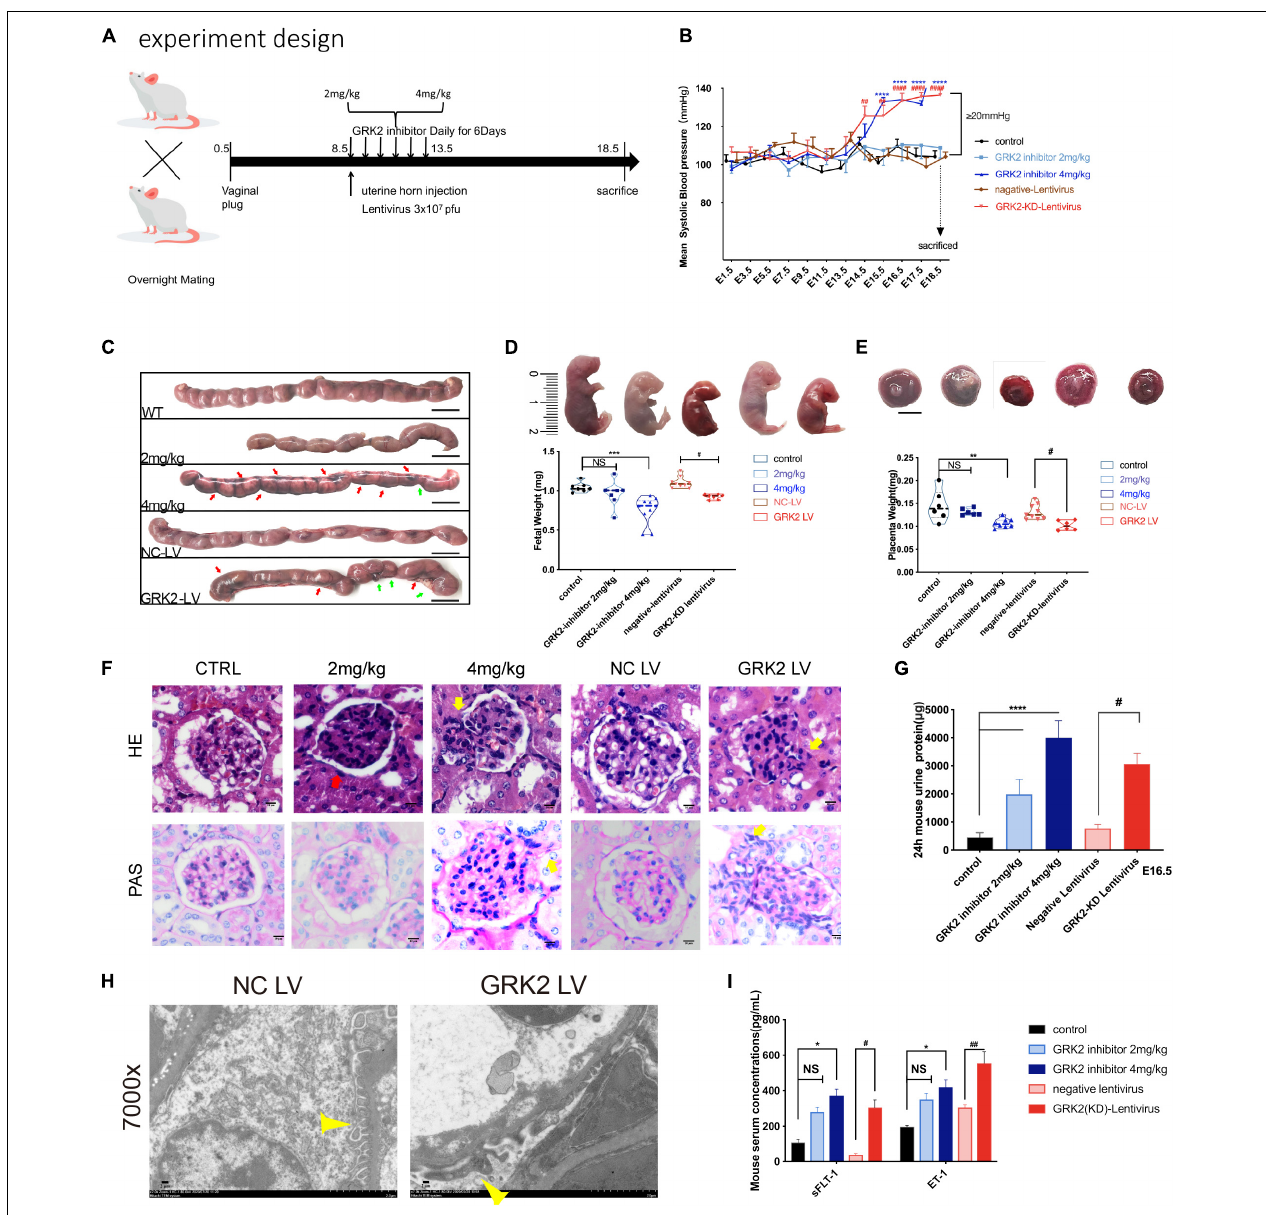
FIGURE 2 | Knockdown or inhibition of GRK2 in placenta induces PE-like phenotype:hypertension, proteinuria, and angiogenic imbalance in mice. (A) Experimental design. For each group, n = 6–10 mice. (B) Blood pressure was taken in mice with/without placental knockdown or inhibition of GRK2. n > 6, Mean ± SEM. (C) Gross morphology of uterus at E18.5 shows the spontaneous hemorrhage and resorptions of embryos in uteri of GRK2 deficient groups. Green arrows, fetal resorption; red arrows, intrauterine hemorrhage. (D,E) Knockdown or inhibition of placental GRK2 induced embryo growth restriction and placenta growth restriction. (F,G) Glomerular histopathology assessment by HE (upper panel) and PAS (lower panel) staining of untreated mice and mice treated with GSK180736A (2 or 4 mg/kg), and mice receiving intrauterine injections with non-target/GRK2-knockdown lentivirus. Scale bar, 10 µ m. Mesangial hyperplasia (yellow arrow) and decreased capillary density (red arrow) are shown in GRK2-knockdown/inhibition group. (H) TEM analysis of glomerulus. Pathological podocyte fusion in GRK2-knockdown group and the podocytes in NC-LV group are indicated by thin yellow arrows; 7,000 × magnification, Scale bar, 2 µ m. (I) the sFlt1 and ET-1 abundance in serum of E18.5 mice, as determined by ELISA. sFlt1, soluble fms-related tyrosine kinase-1; ET-1, Endothelin-1. All data are represented as X ± SEM from each experiment ( n = 6–10 mice, each assayed individually), NS, not significant; * P < 0.05, ** P < 0.01, *** P < 0.001, **** P < 0.0001 versus control mice group; # P < 0.05, ## P < 0.01, ### P < 0.001, #### P < 0.0001 versus NC-LV mice group.